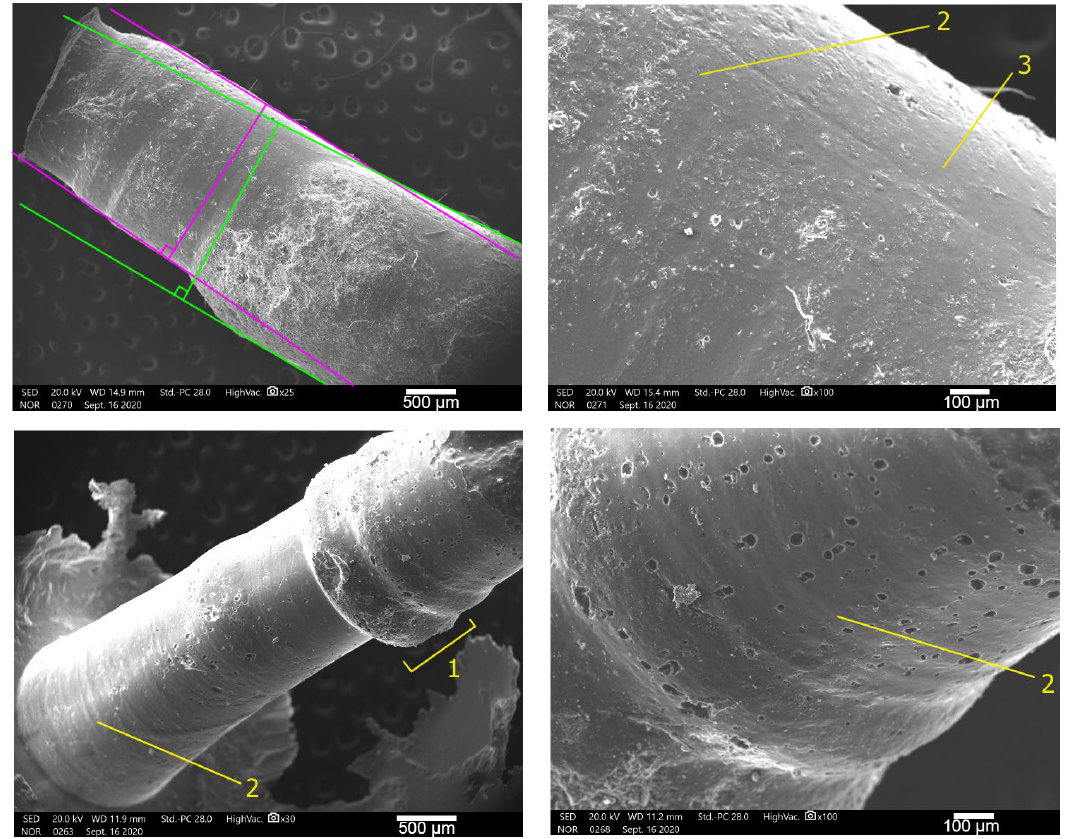
Figure 12: SEM images of perforation icasts of beads from the Vivé site (Martinique): MA-02-033 made of amethyst (top) and MA-02-006 made of rock crystal (bottom). The bead MA-022-33 shows two axes of perforation and we can guess striations (2), probably partly erased by the wear due to the use of the object (3). The cast of the perforation of bead MA-02-006 shows striations related to the perforation process (2), as well as very marked pushing marks